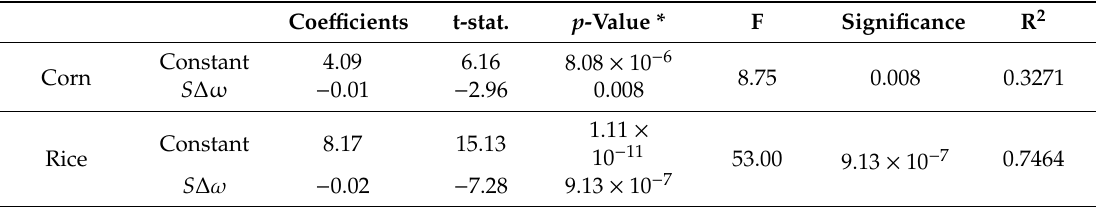
Table 9. Results of regression analysis for the sustainable CO 2 emissions index. Coe ffi cients t-stat. p -Value *